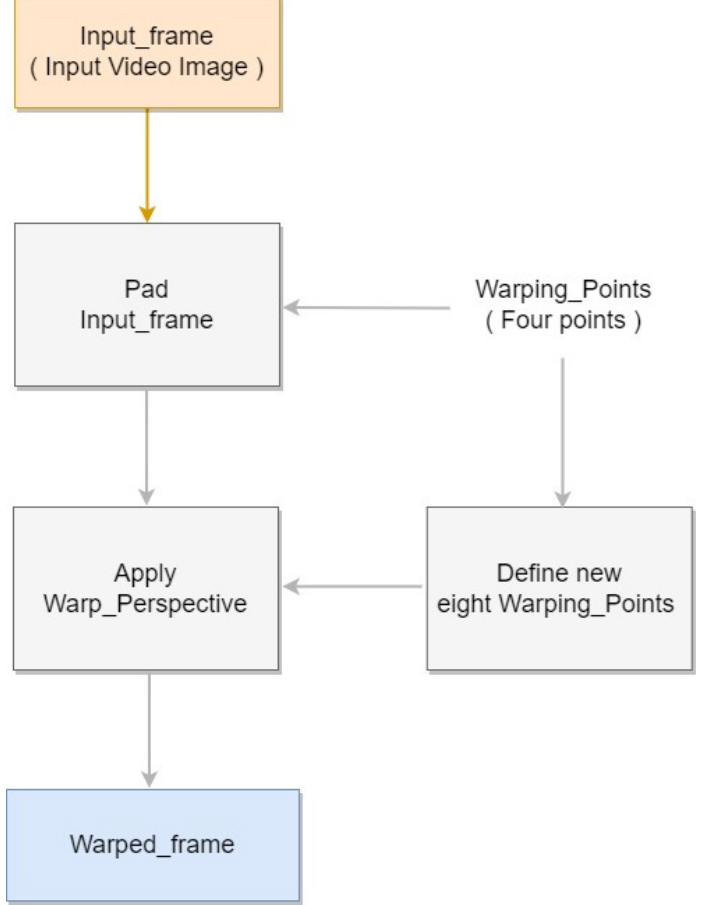
Figure 4. Perspective Transformation block diagram.